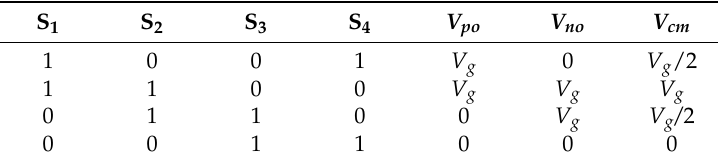
Table 1. The switching states and their